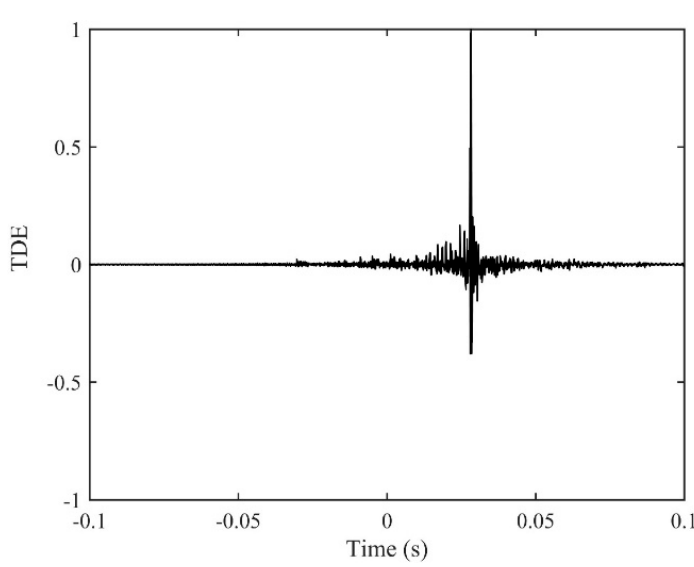
Figure 16. The proposed ADPHAT algorithm for TDE when D = 50 m.